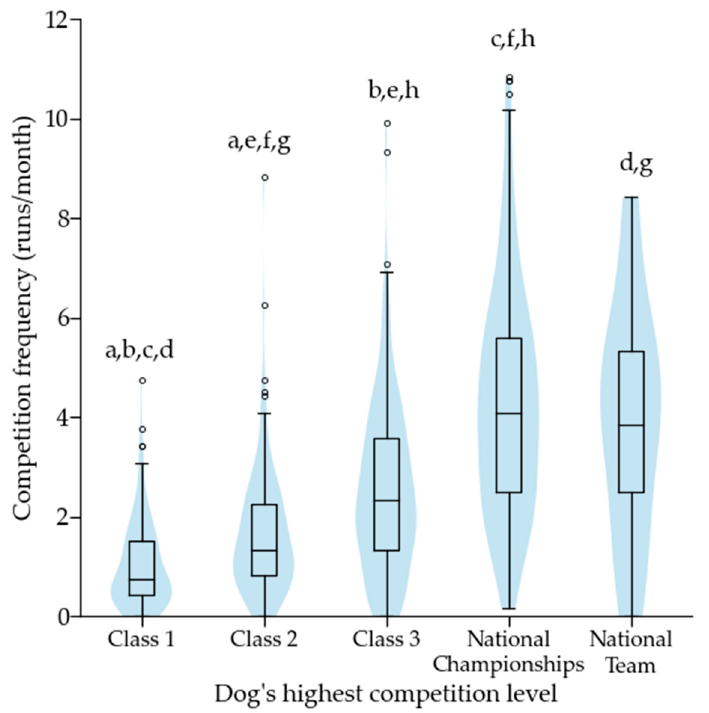
Figure 6. Average number of monthly competition runs during 2019 according to a dog’s highest competition level. Same letter indicates a significant difference between two height categories. For letter a, p < 0.01, and for letters b to h p < 0.001. Outliers are plotted as “ ◦ ”.